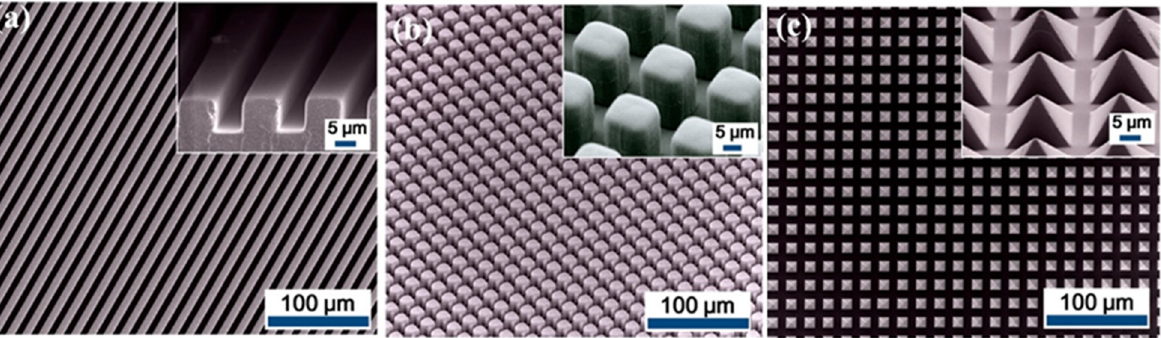
Figure 11. Regular structures on the material surface: ( a ) line-like structures; ( b ) cube-like structures, and ( c ) pyramid-like structures (Reproduced with permission [77]. Copyright 2012 American Chemical Society).